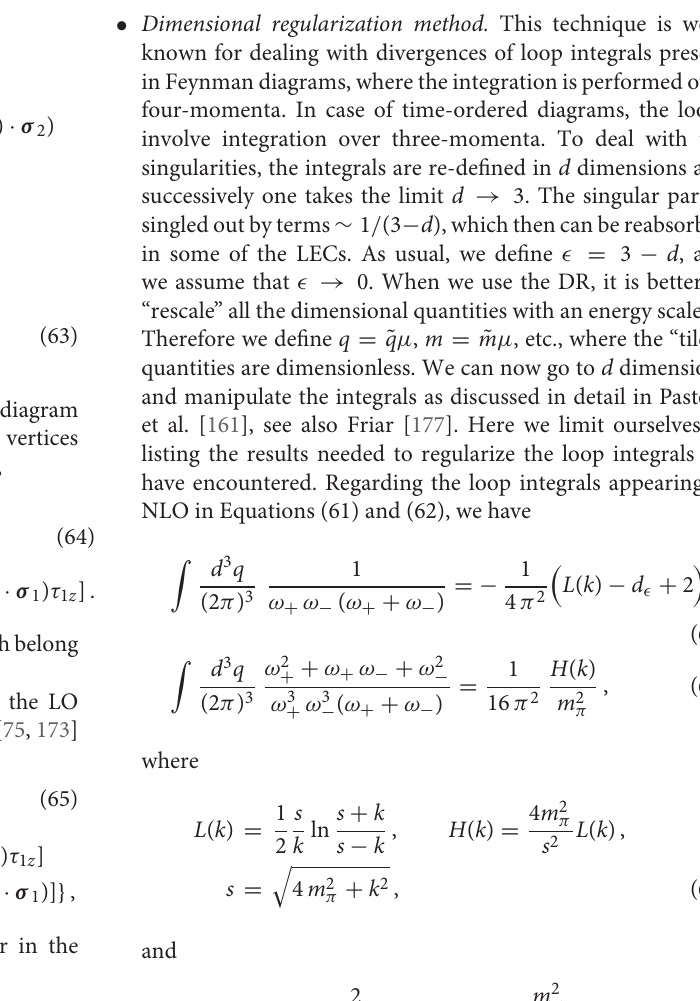
h V , and h V in Equation (19). We have [75, 1 2